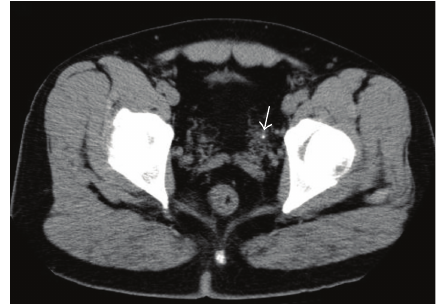
Figure 1: CT showing a small ureteral stone located at the ureterovesical junction area